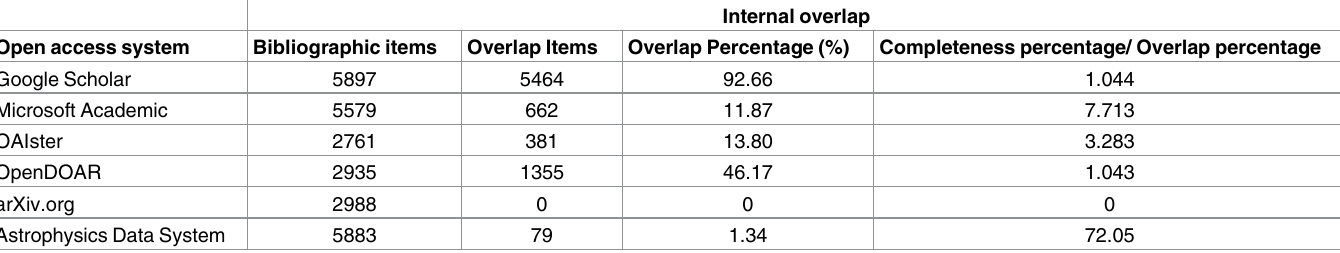
Table 1. Internal overlap of the publication list of the 2001–2013Nobel Laureatesin Physics in the open accesssystems.